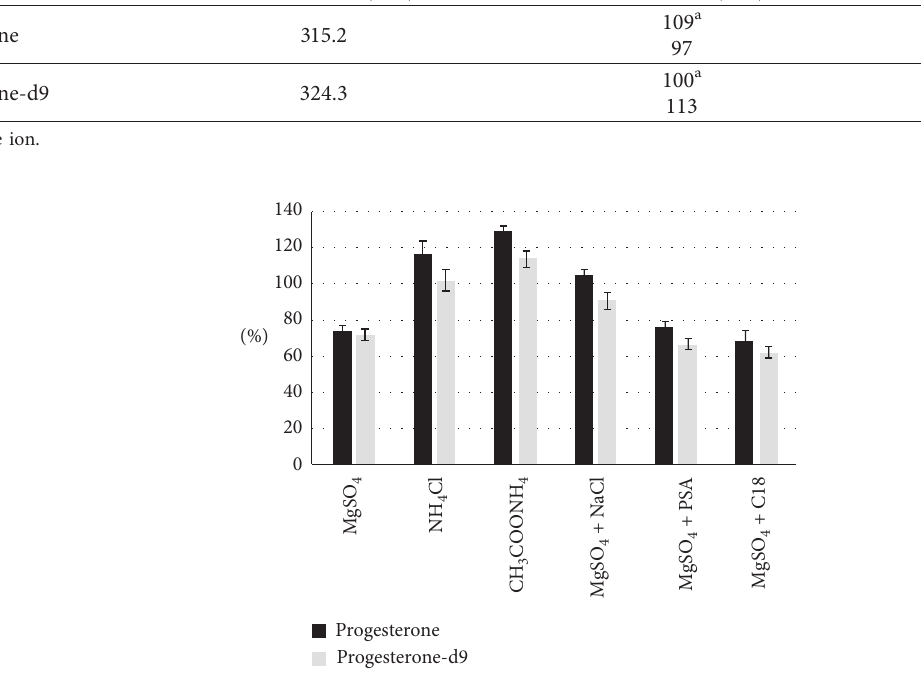
Figure 2: Progesterone and progesterone-d9 extraction recovery of different salting-out